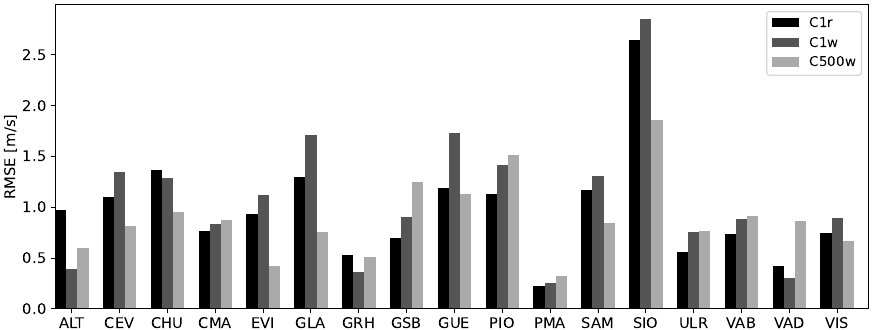
Figure 5. Root mean square error (RMSE) of the mean up-valley wind (10:00–14:00) for the main simulations.